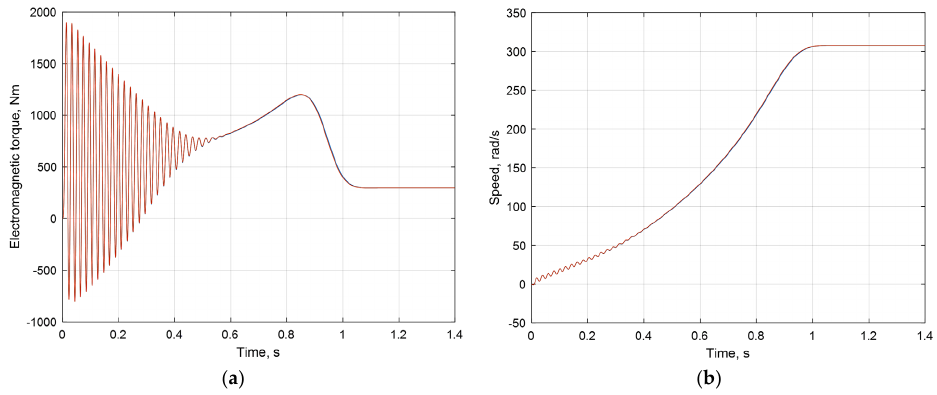
Figure 10. Simulation results of the IM’s starting mode: electromagnetic torque ( a ), rotation speed ( b )—etalon results (red), AVIS method of the 1st and 2nd order (blue).